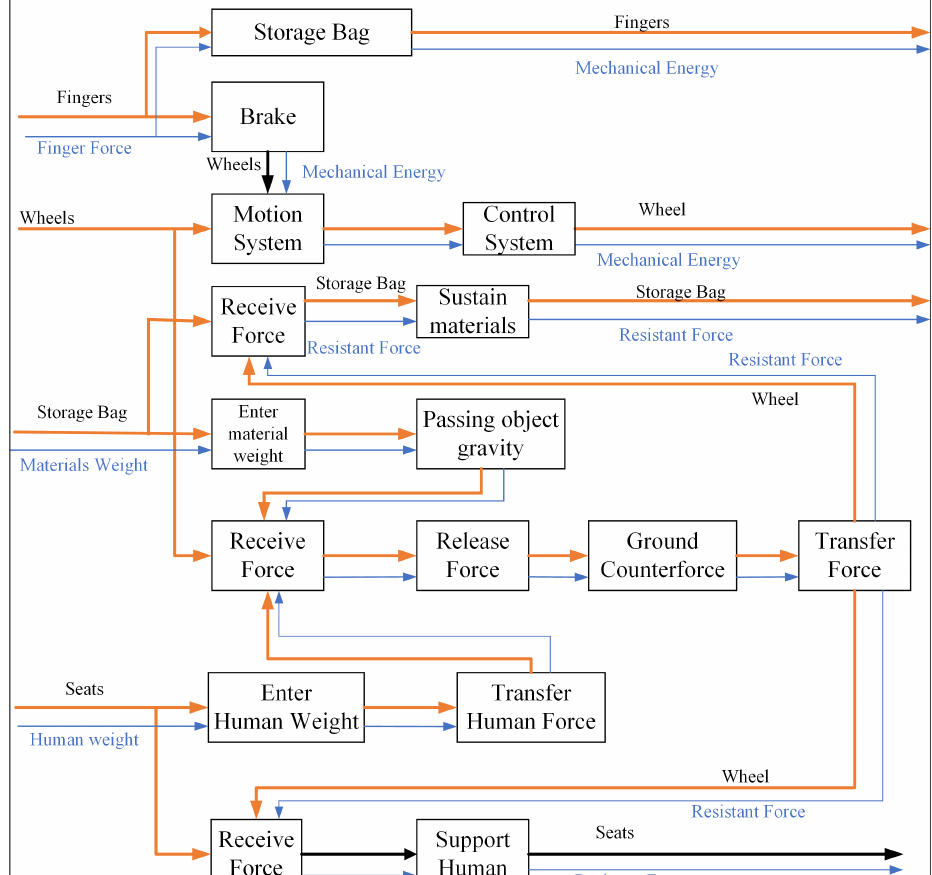
Figure 1. A functional diagram for rollator